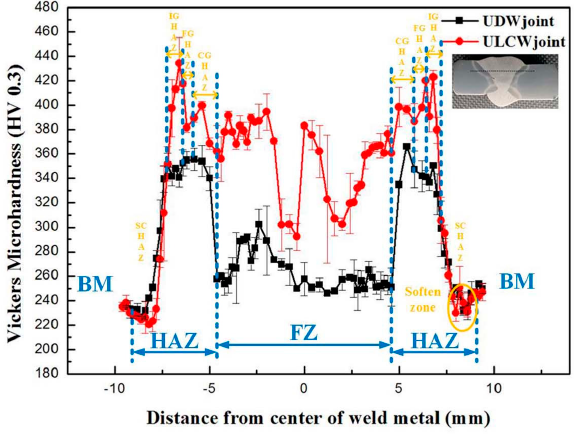
Figure 8. Micro-hardness measurements on the welded joints.